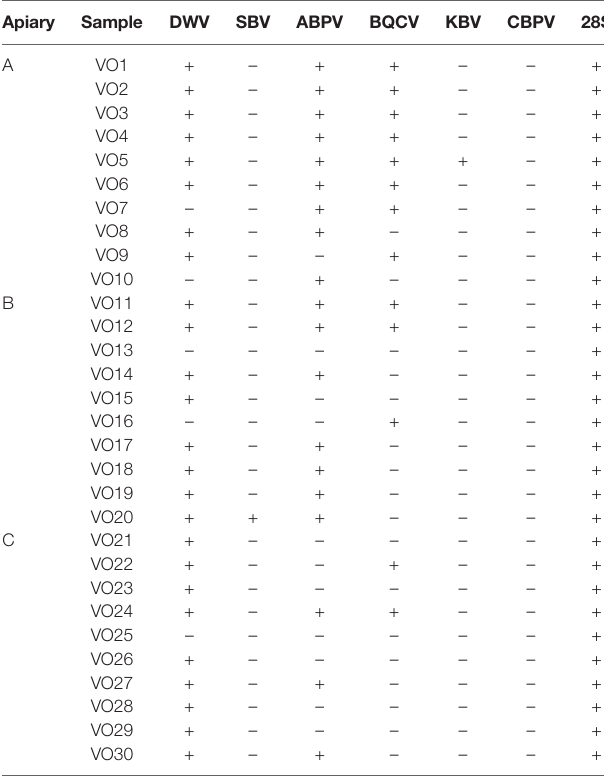
TABLE 1 | Detection of honeybee viruses and 28s ribosomal RNA in V.orientalis by multiplex PCR.